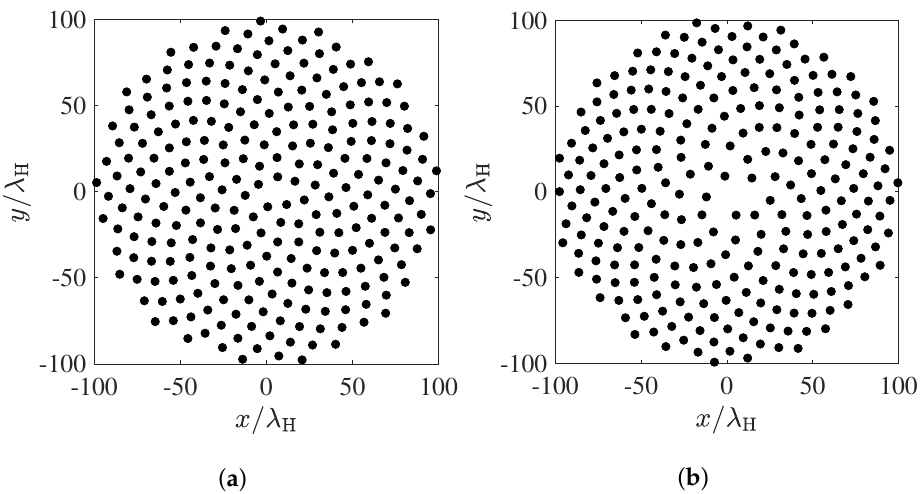
Figure 2. ( a ) Array layout of the 256 − element Fermat spiral array [15] and ( b ) array layout of the 256 − element parameter − optimized spiral array.